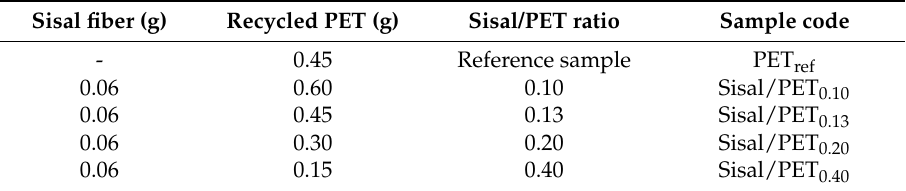
Table 1. Composition and respective reference codes of the electrospun